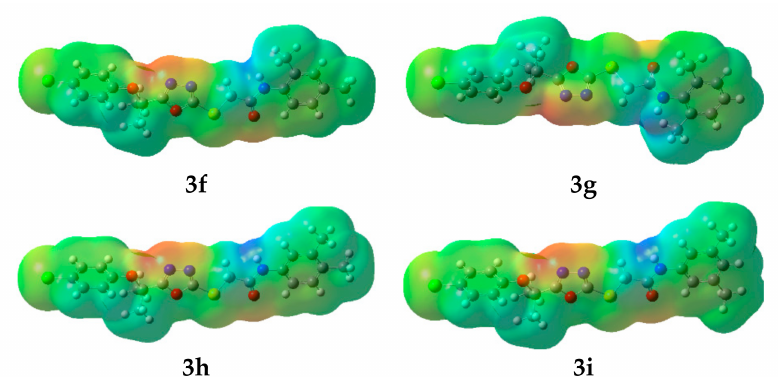
Figure 7. The molecular electrostatic potential surfaces of the oxadiazoles derivatives. Color code of atoms: C—grey, Cl—light green, H—light grey, N—blue, O—red,